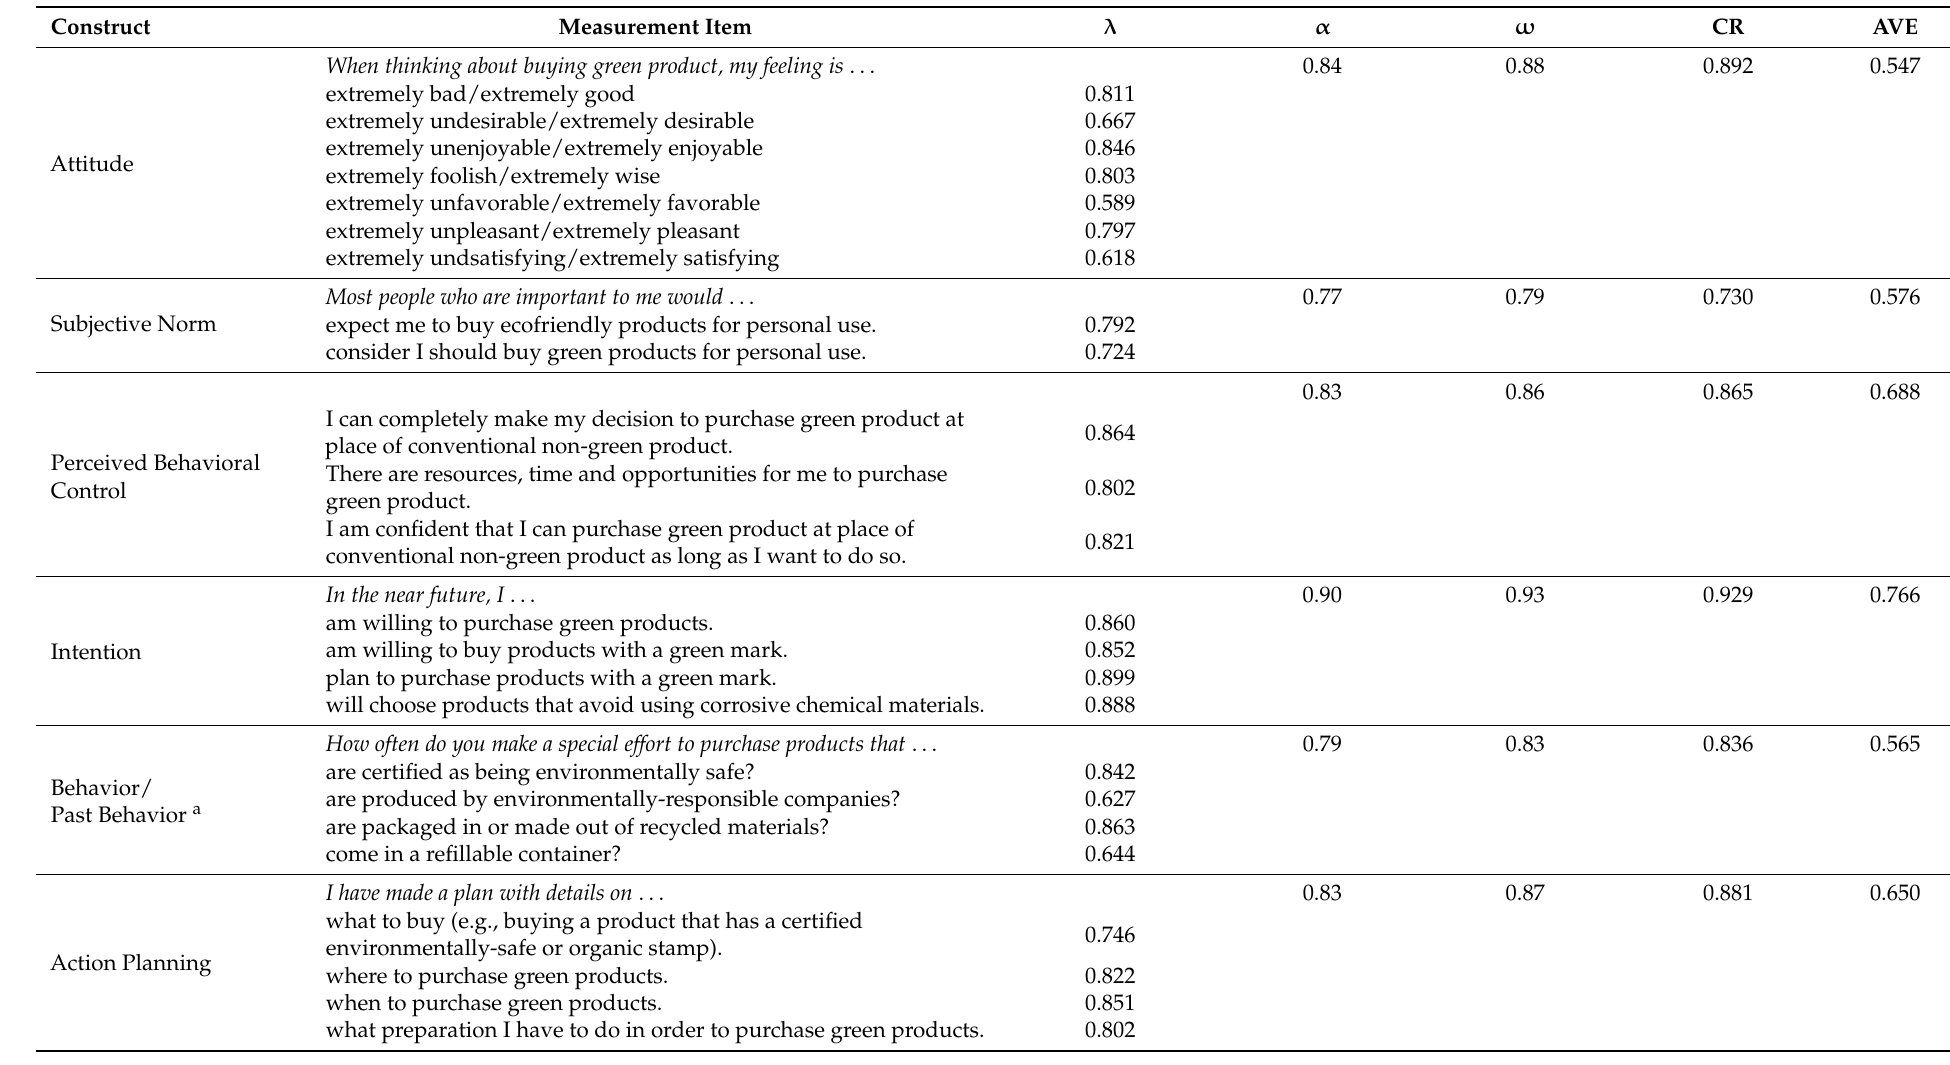
Table 1. Measurement Items and Indicators of Model